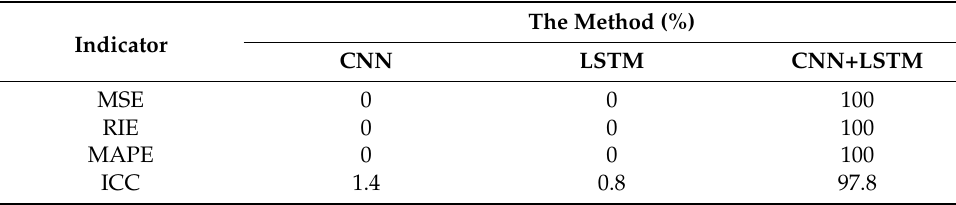
Table 8. Percentage of the winning methods according to the indicator criteria. Indicator